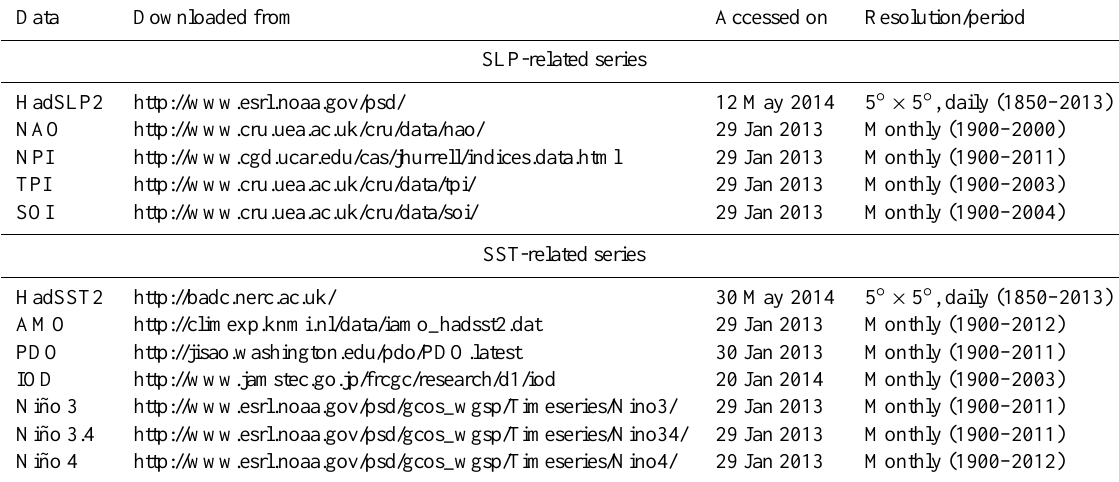
Table 2. Overview of SLP, SST and related time series.